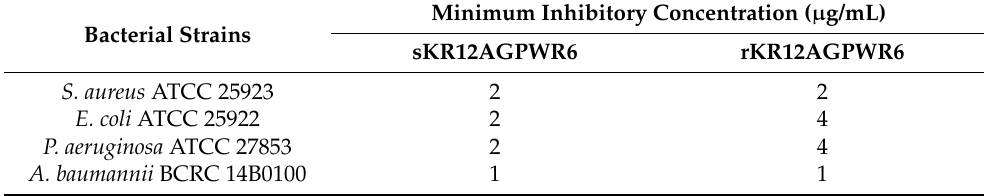
Table 1. MICs of sKR12AGPWR6 and rKR12AGPWR6 against Gram-positive and Gram-negative bacteria.